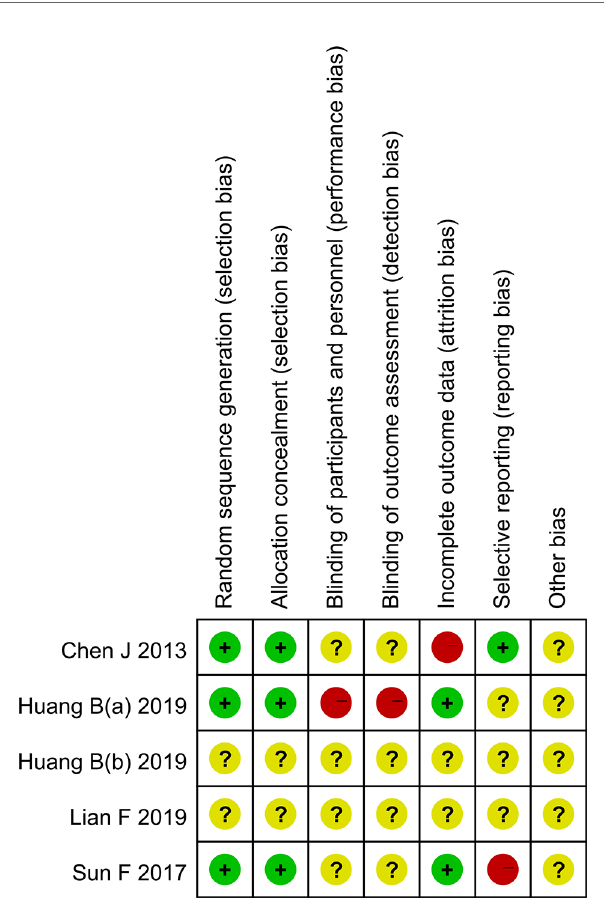
FIGURE 2 | The risk of bias graph.